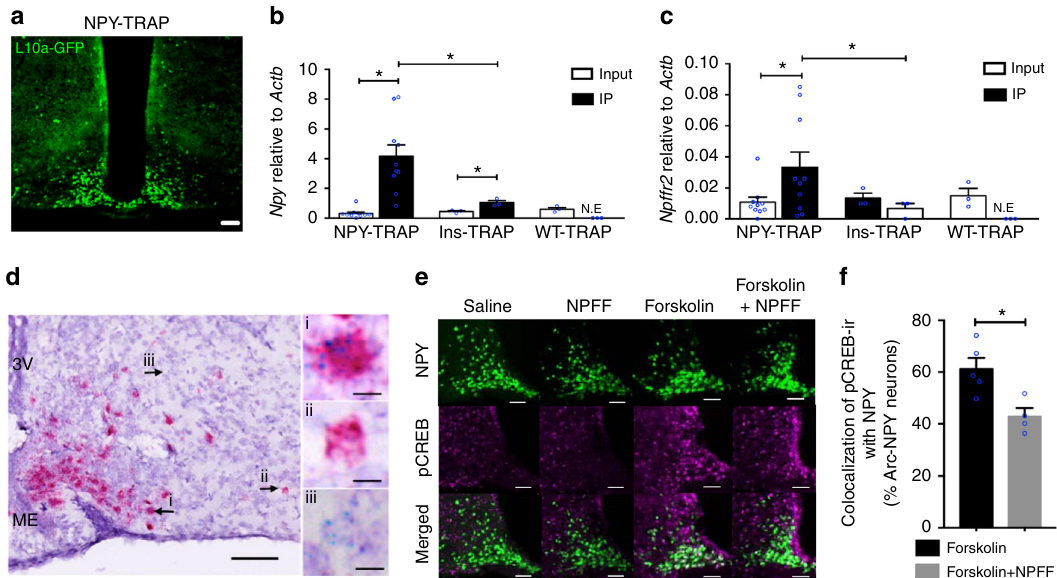
Fig. 7 Colocalization and effects of direct NPFFR2 signalling on NPY neurons. a Representative image of GFP expression in the Arc of a NPY-TRAP mouse brain. Scale bar = 100 µ m. b, c Quanti fi cation of the expression of Npy and Npffr2 mRNA in the input and immunoprecipitated (IP) RNA isolated from the Arc of NPY-TRAP ( n = 10), Ins-TRAP ( n = 3) and WT-TRAP ( n = 3) mice. One-way ANOVA was used to determine difference between groups. ∗∗ p < 0.05 as indicated by bar. N.E, gene is not expressed. d Double chromogenic ISH for Npy (red) and Npffr2 (blue) expression in the Arc. Scale bar = 100 µ m in the image on the left, 10 µ m in images (i), (ii) and (iii). Representative image from three independent experiments. e Representative images of IHC of brain sections for pCREB (magenta) in NPY-GFP mice that received i.c.v. either saline, NPFF (150 µ M), Forksolin (2.5 mM) or NPFF (150 µ M) + Forksoline (2.5 mM). Brains were collected 30 min after i.c.v. injection. Scale bar = 100 µ m. f Quanti fi cation of pCREB-ir-positive neurons colocalized with Arc GFP- labelled NPY neurons expressed as percentage of Arc NPY neurons. Forskolin n = 5, Forskolin + NPFF n = 4. Data are mean ± SEM. One-way ANOVA was used to determine difference between groups. ∗∗ p < 0.05 as indicated by